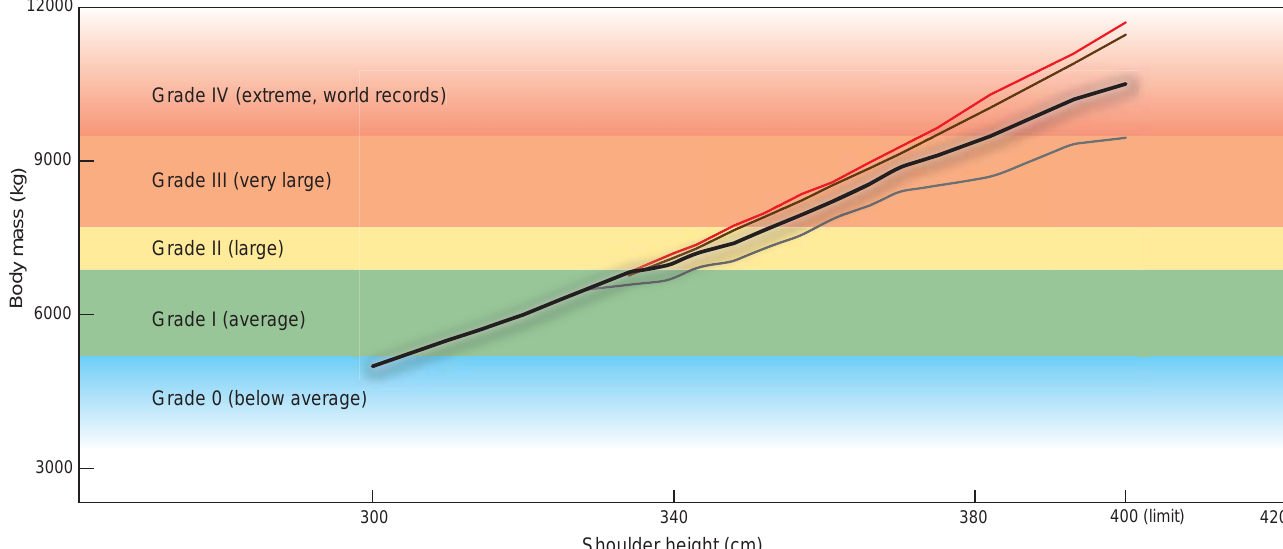
Fig. 10. Different growth curves for Loxodonta africana from average-sized to world record specimens based on isometric growth (red), Laws’ (1975) equations for wild population in good conditions up to average size (brown), Homo sapiens (in optimal conditions) allometric growth (grey), and the proposed allometric growth curve for proboscideans in this study